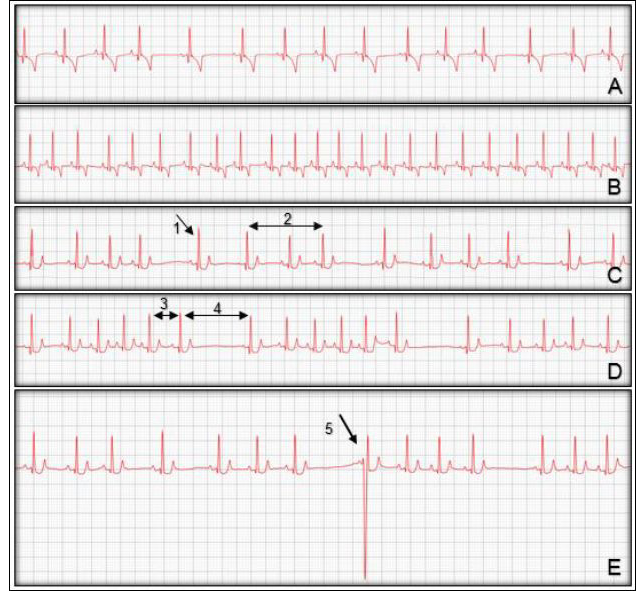
Figure 4. Electrocardiographic tracing in D2 lead, N sensitivity (10 mm/mV), Speed 25 mm/s. A: Sinus rhythm; B: Sinus tachycardia; C: Sinus arrhythmia. The arrow 1 demonstrates a decrease in heart rate at the time of expiration and arrow 2 increases at the time of inspiration; D: Sinus arrhythmia with presence of “Sinus